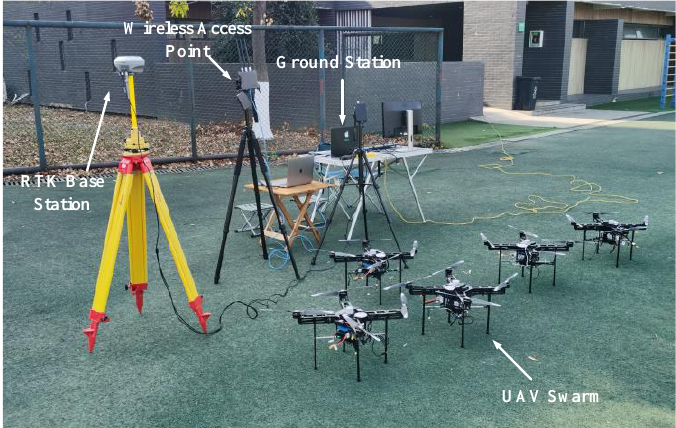
Figure 11. The flight system of UAV swarm.